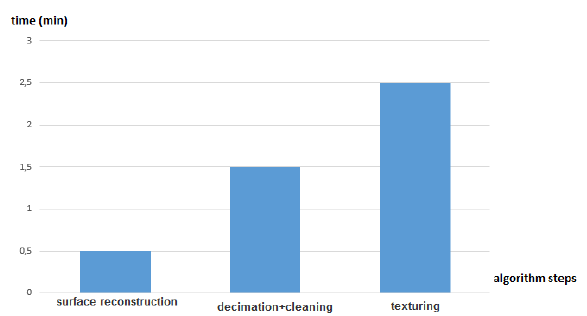
Figure 9. Performance evaluation of a chunk of 10s of